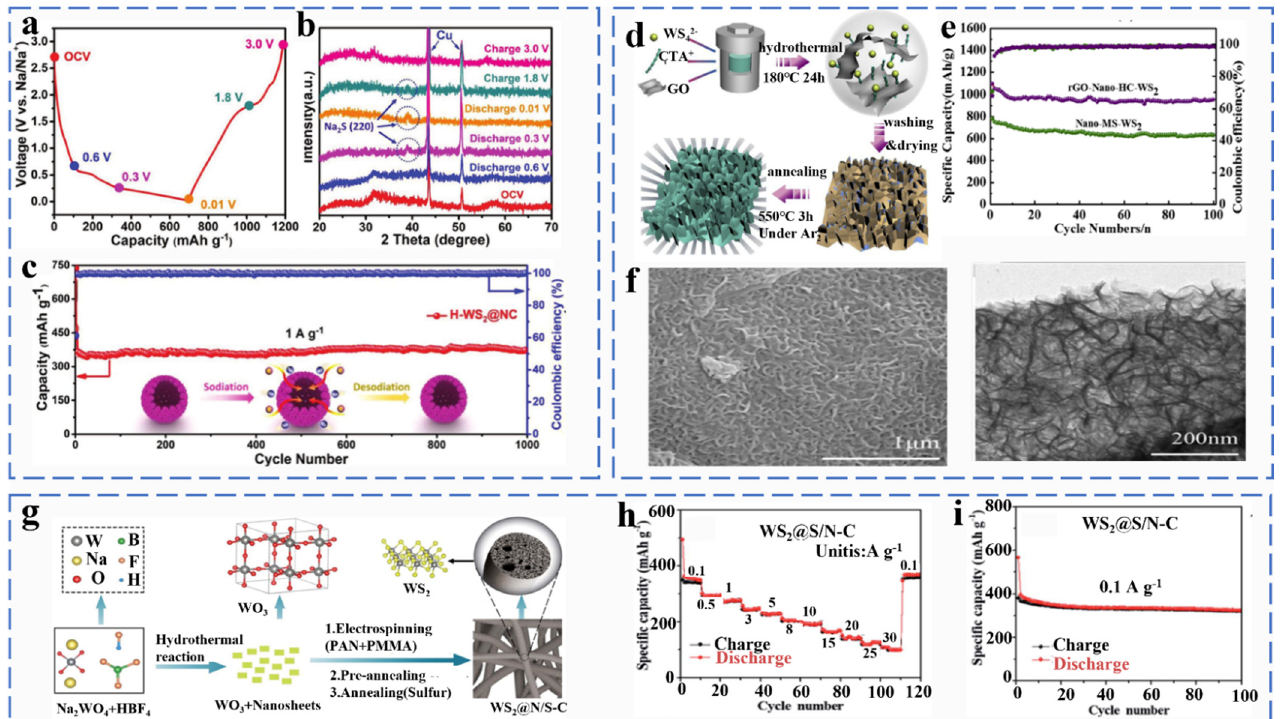
Figure 13. ( a ) Charging/discharging profiles of initial cycle at 0.1 A g − 1 . ( b ) The ex situ XRD patterns of H-WS 2 @NC electrode at different cut-off potentials during the initial discharge/charge process.